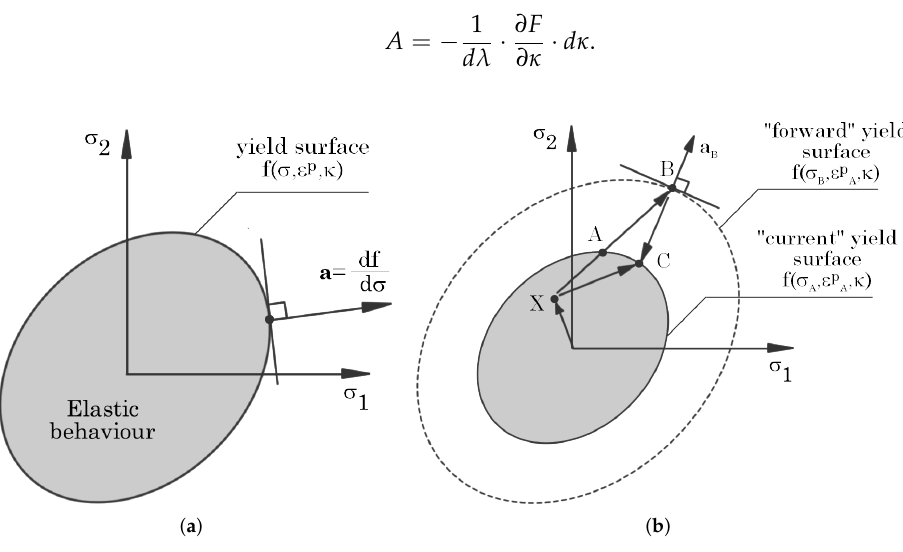
Figure 2. ( a ) Flow vector representation. ( b ) Stress returning